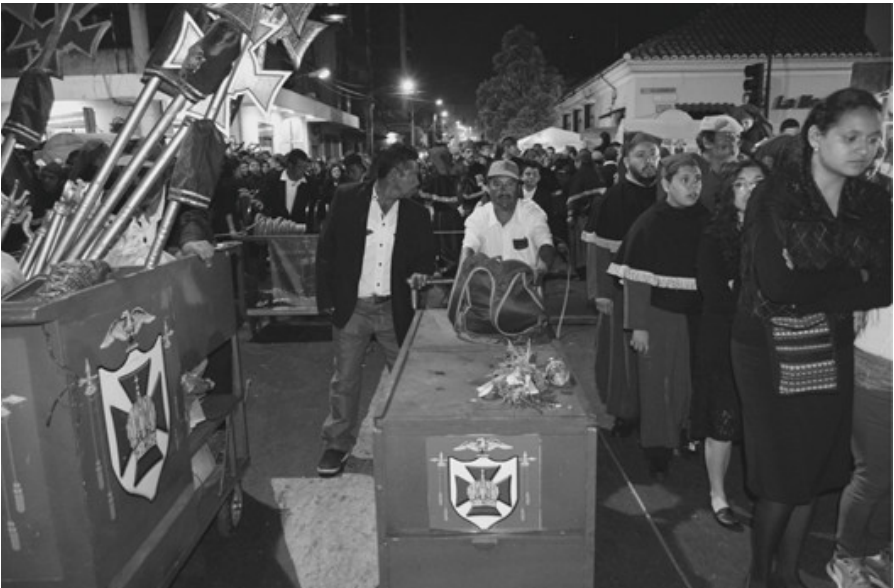
Figure 1. Dividing rope marking the processional area along with box of tools belonging to the Guild of the Rope during the Procession of Jesus the Nazarene of the Miracles, “King of the Universe”, Palm Sunday 2017. Photo: Karen Ponciano.